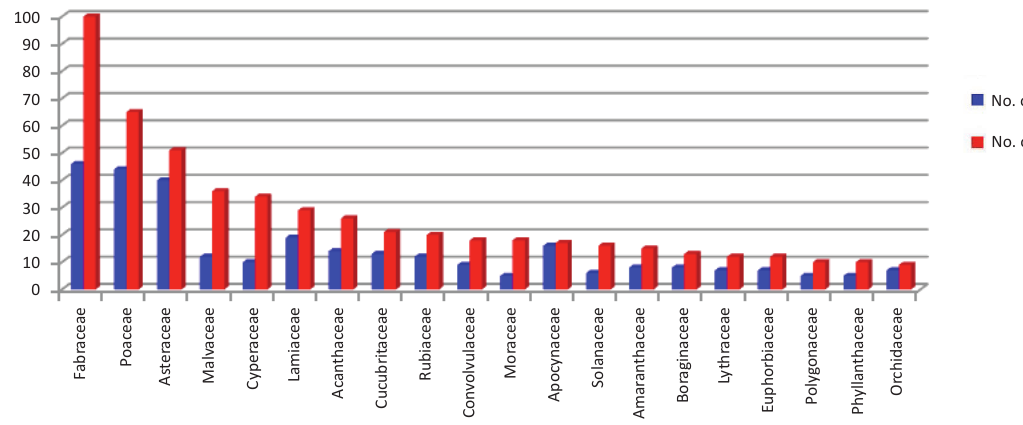
Figure 6. Largest families with their genera and species in dicots and monocots